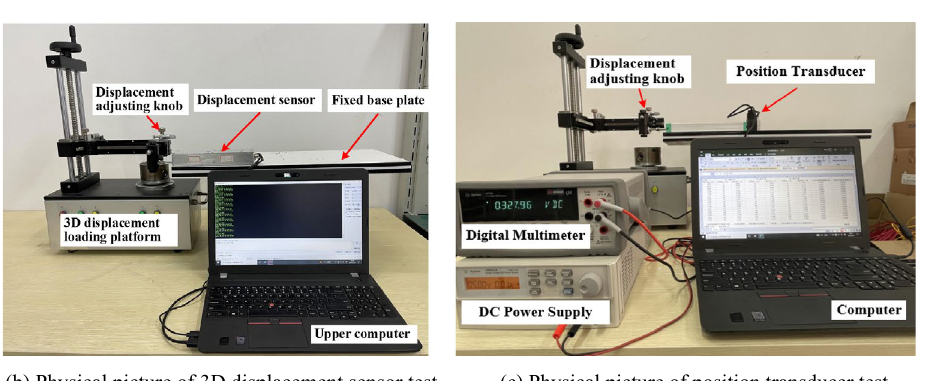
3D displacement loading platform